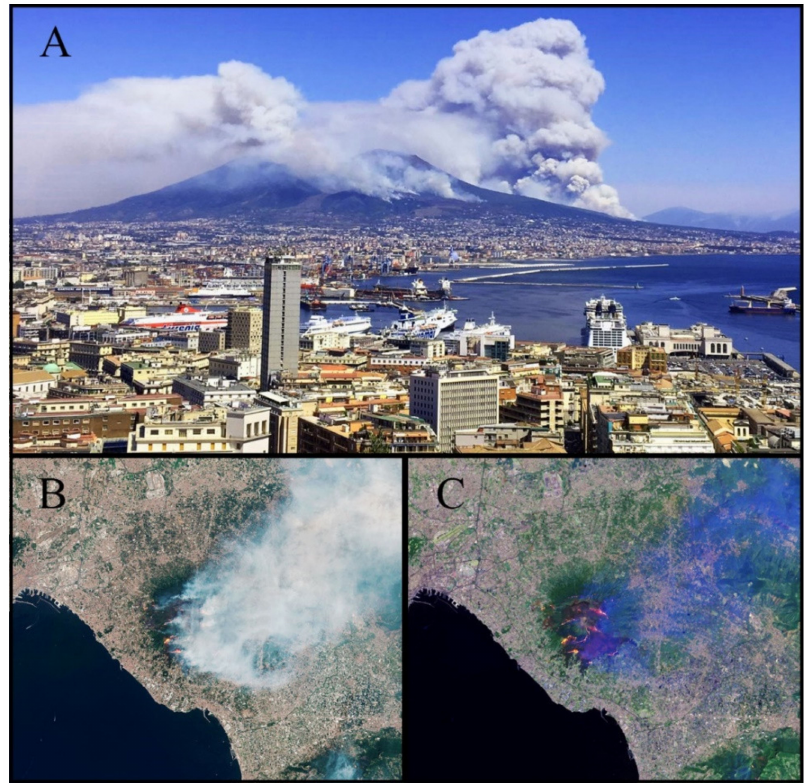
Figure 1. Forest fires in Vesuvius National Park on 12 July 2017. ( A ) Photograph courtesy of Caroline von der Tann, taken from the Bay of Naples. ( B , C ) Modified (cropped) remote-sensing images from Copernicus Sentinel data (2017), processed by ESA, CC BY-SA 3.0